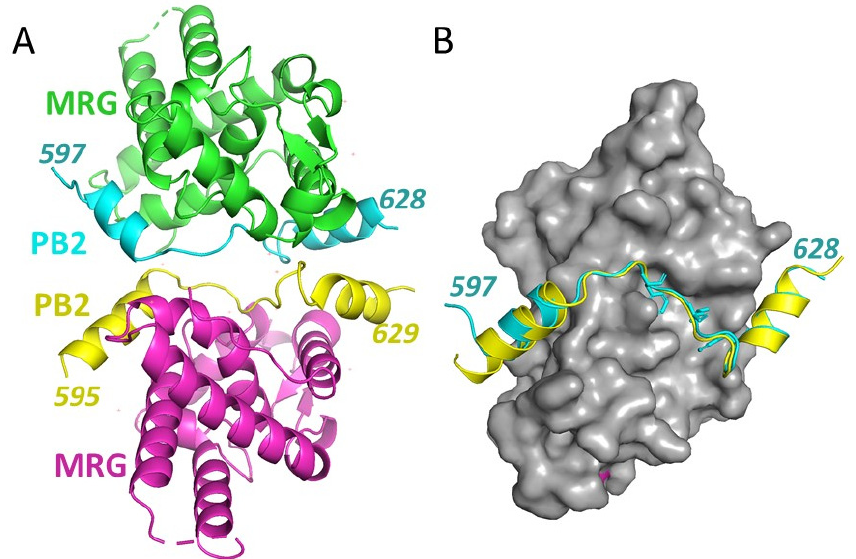
Figure 2. Crystal structure of MRG PALB2 complex. ( A ) Cartoon representation of two complexes in an asymmetric unit, with MRG chains shown in green and magenta and PALB2 peptides in cyan and yellow. N- and C-terminal amino acids modeled for each PALB2 peptide are shown. ( B ) Two complexes were superimposed by the MRG subunits (shown in the grey surface representation), resulting in the overlap of two PALB2 597 − 630 peptides.